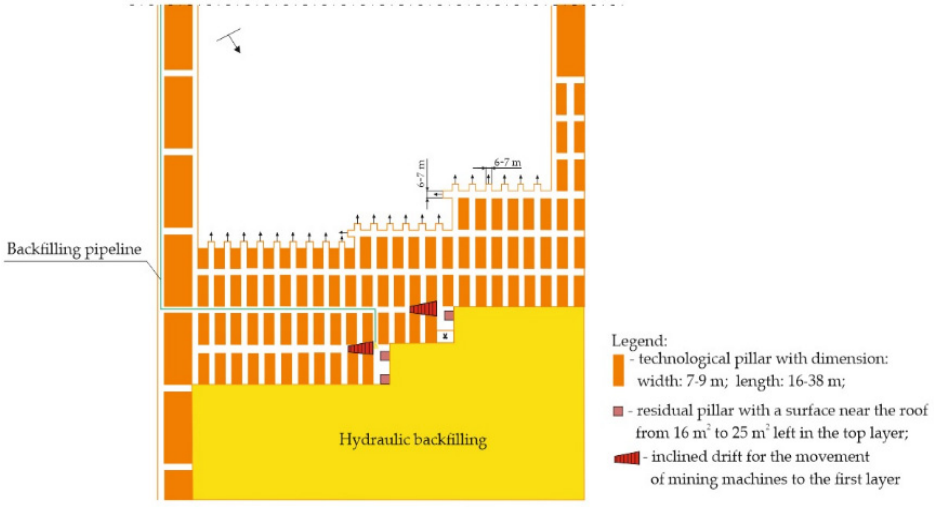
Figure 19. A two-layer room and pillar mining method with a hydraulic backfill in the case of the exploitation gate conditions made of rocks strongly prone to rock bursts.